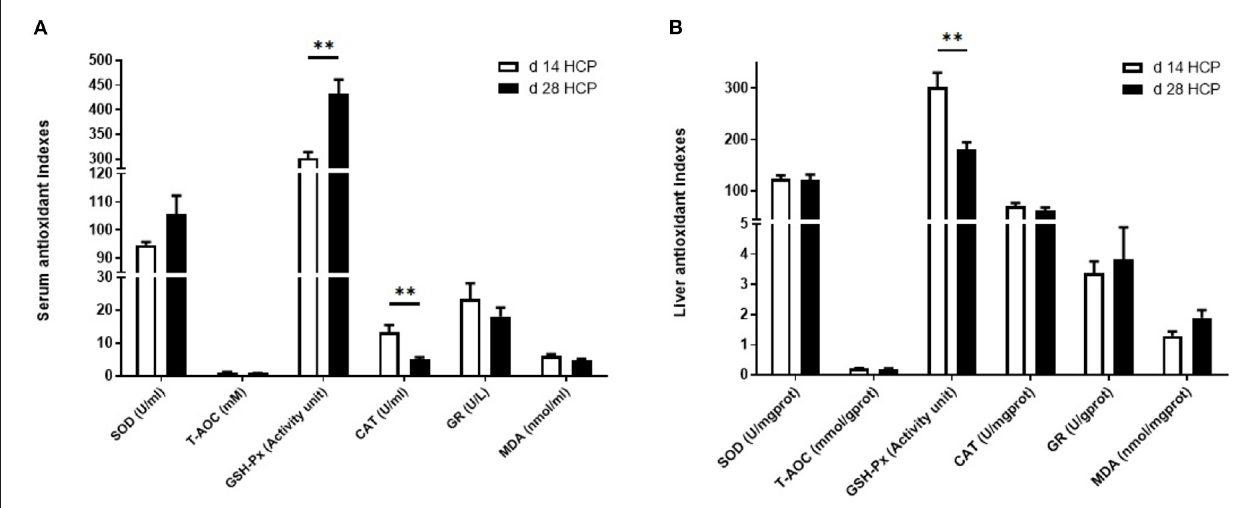
FIGURE 3 | Effect of HCP meal-based diet on serum and liver antioxidant indexes of Magang geese on day 14 and 28. (A) Serum antioxidant indicators. (B) Liver antioxidant indicators. **Mean extremely significant difference ( p < 0.01).